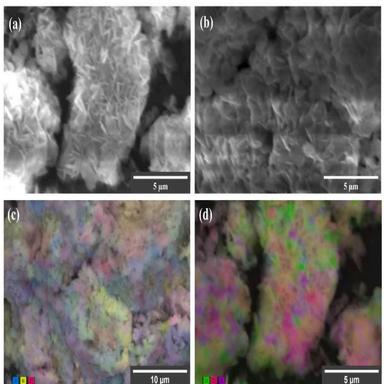
SEM images and color mapping of two BZO samples: BZO-1 (a and c) and BZO-2 (b and d).